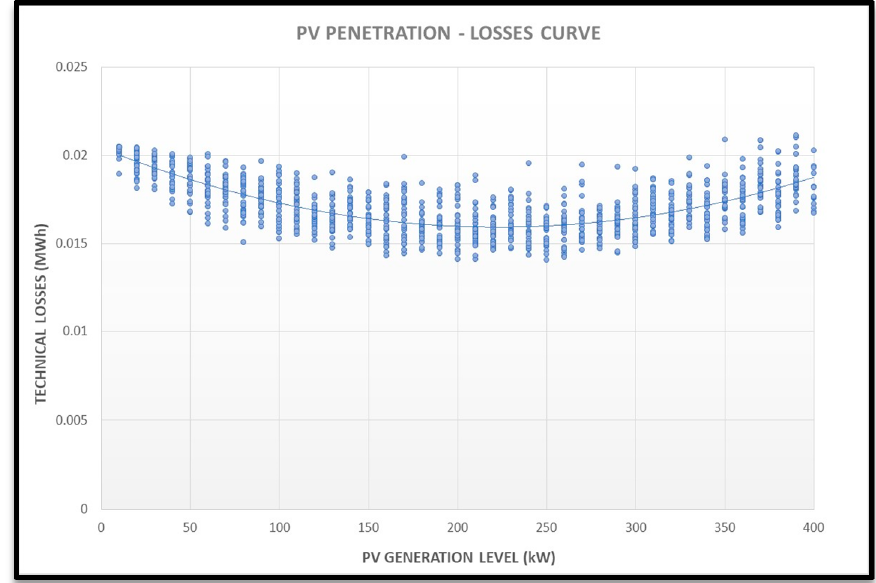
Figure 4. Total grid losses from all scenarios and PV penetration levels.